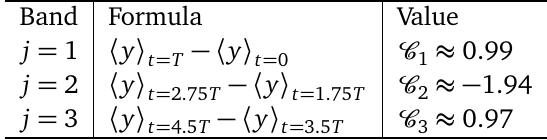
number. Related methods to determine the Chern number have been proposed in Refs. [ 61,